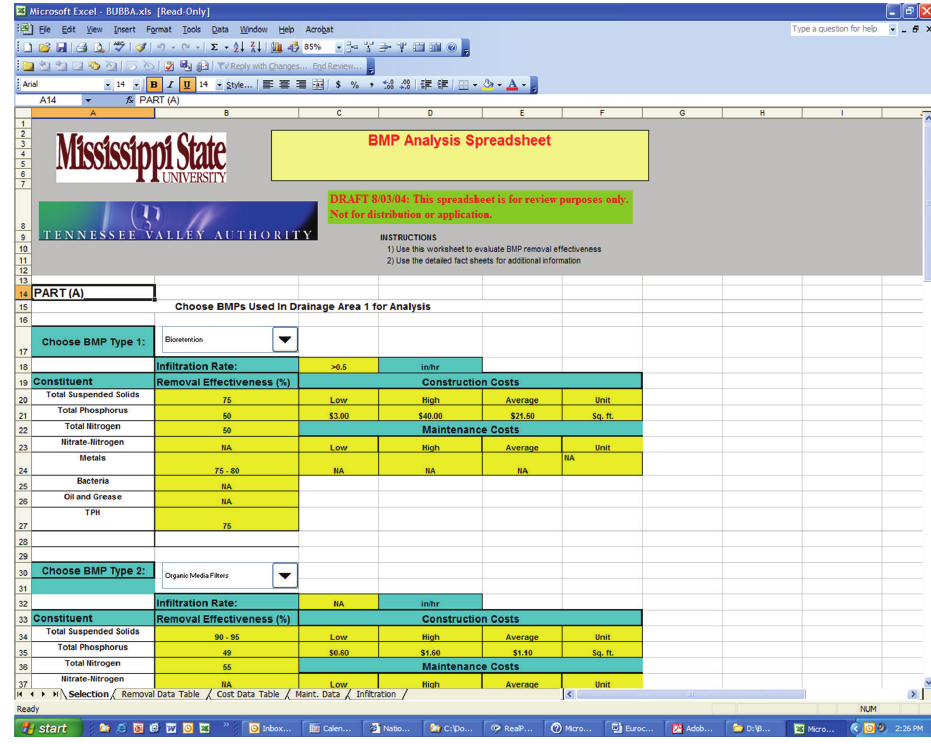
Figure 1: Part A of the Selection worksheet.